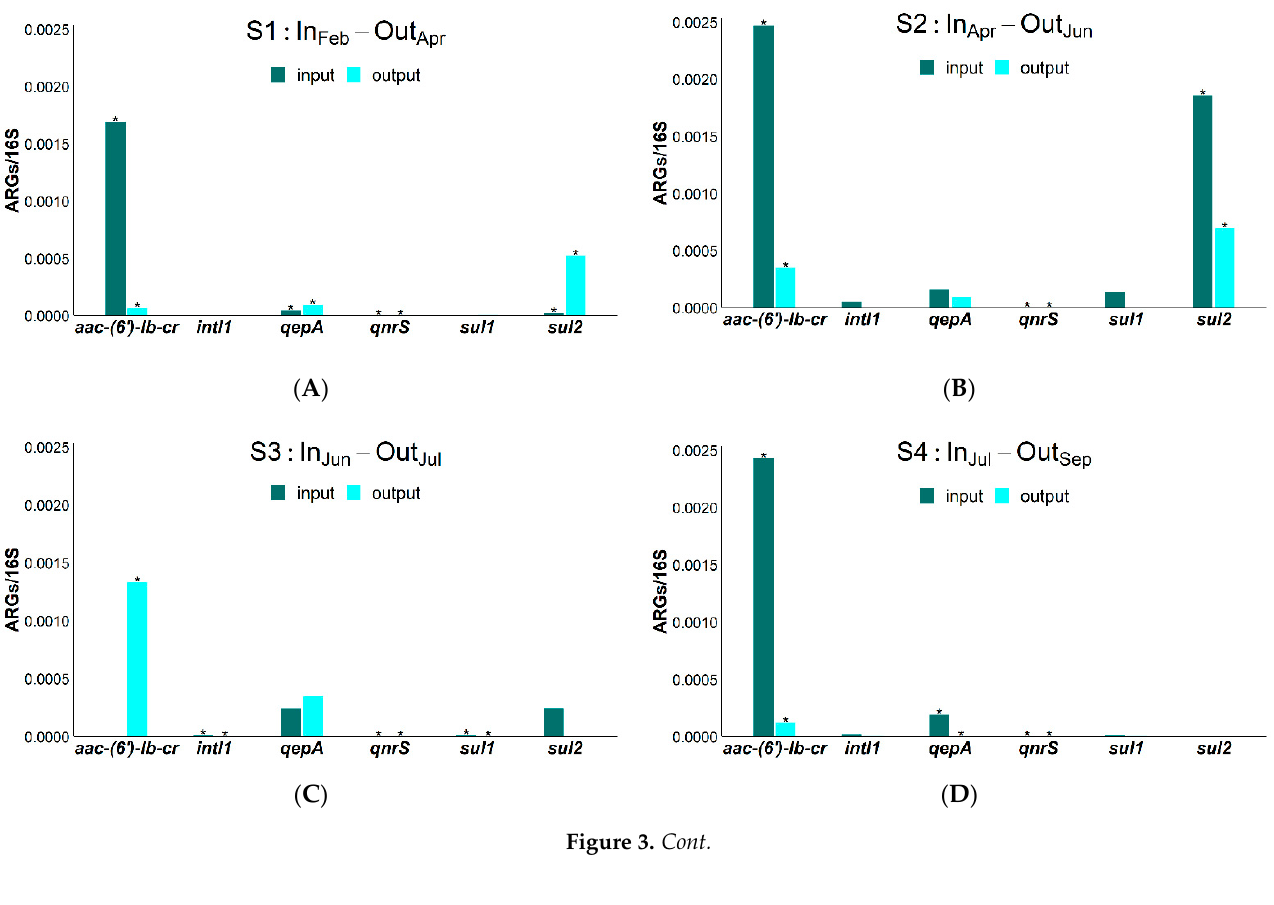
Figure 3A–E report the CIP and SMX genes investigated in the input (fresh waste) and output samples (digestate). All genes ( sul1, sul2, qnrS, qepA, aac-(6 ′ )-Ib-cr, intI1 ) searched for were found, even if at variable abundances, depending on the sampling and the specific gene considered. The relative abundances of sul1 and intI1 were generally quite low; the sul2 gene was higher than sul1 and intI1 . In the case of fluoroquinolones, aac-(6 ′ )-Ib-cr was the most abundant gene (from 4.8 × 10 − 5 to 1.2 × 10 − 1 ); in fact, qnrS and qepA were found from 0 to 3.4 × 10 − 7 gene copies and from 2.1 × 10 − 6 to 4.3 × 10 − 4 gene copies, respectively. As regards gene abundance between input and output samples, a removal percentage was found only in the cases of the sul1, intI1 and aac-(6 ′ )-Ib-cr genes (Table 1).